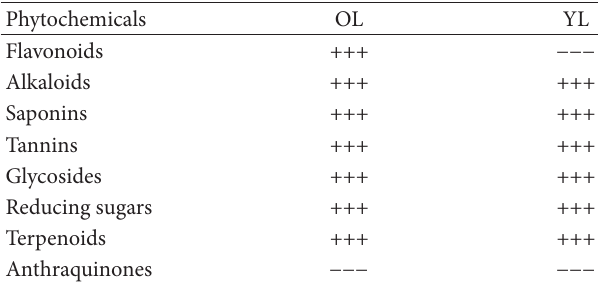
Table 1: Preliminary screening of ethanolic leaf extract of V. amygdalina